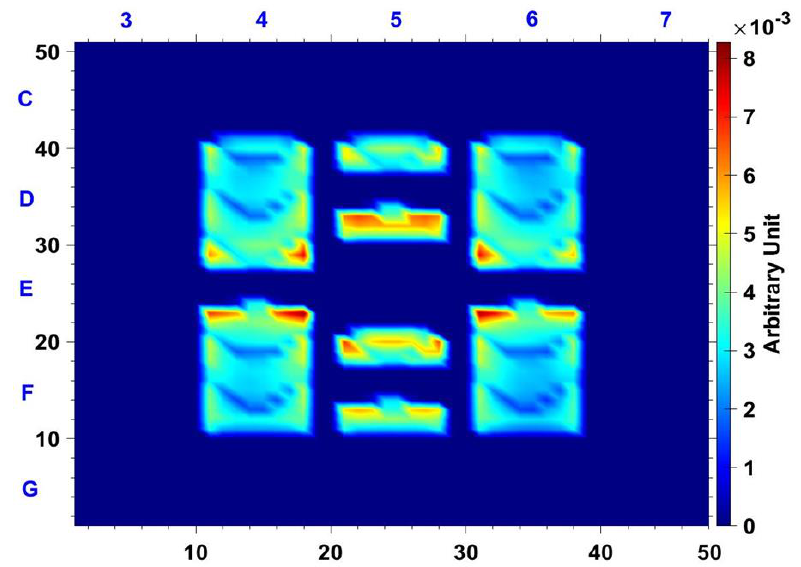
Figure 13. Energy deposition for MSTR-HPC clean core (C–G and 3–7 grid reference labels; blue colored).